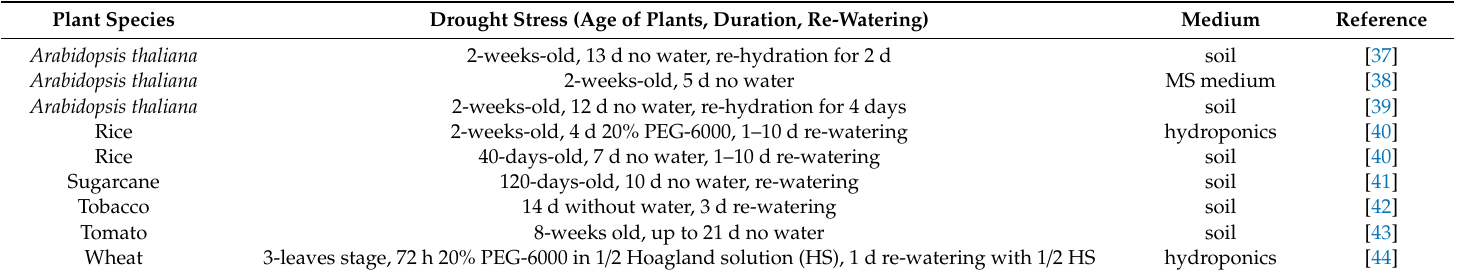
Table 2. Exemplary experimental design for testing drought tolerance in di ff erent plant